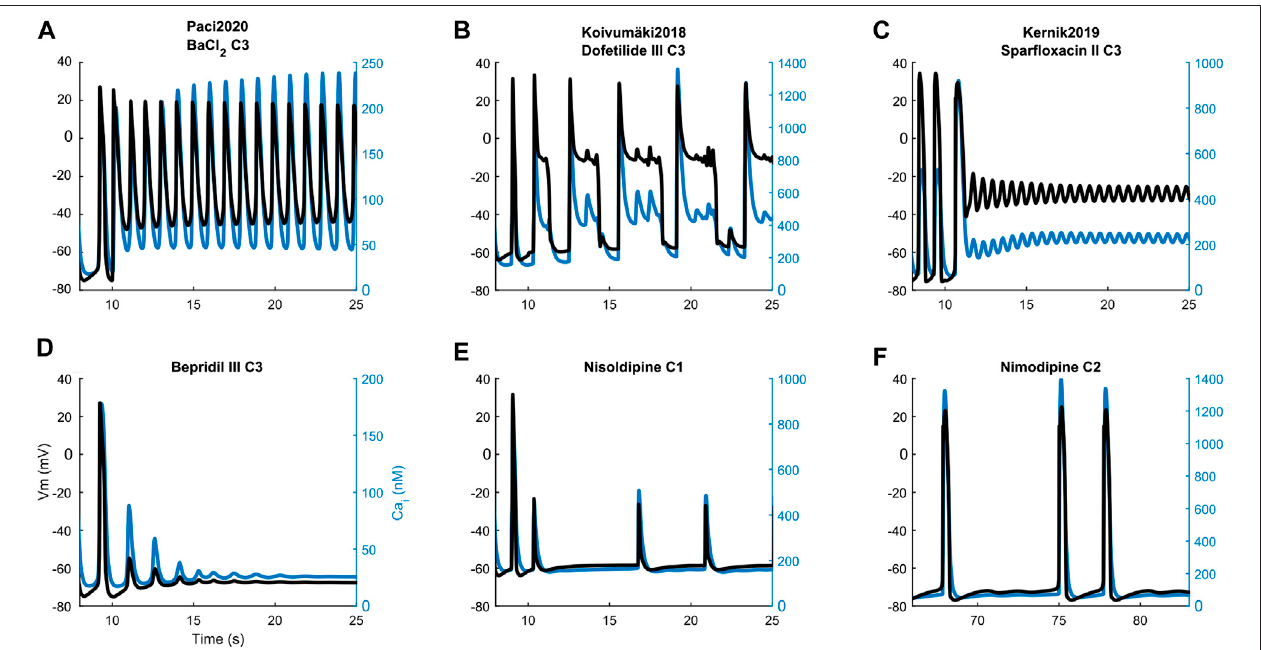
FIGURE 8 | Illustrative action potential (black) and Ca 2+ transient (blue) arrhythmic rhythms, abnormalities and the cessation of spontaneous activity produced by thethreemodels.Paci2020:repolarizationfailure (A) ,quiescence (D) .Koivumäki2018:earlyafter-depolarizations (B) andresidualactivity (E) .Kernik2019:repolarization failure (C) and irregular rhythm (F) . The drug concentrations are reported as C1, C2 and C3, consistently with Supplementary Table S2